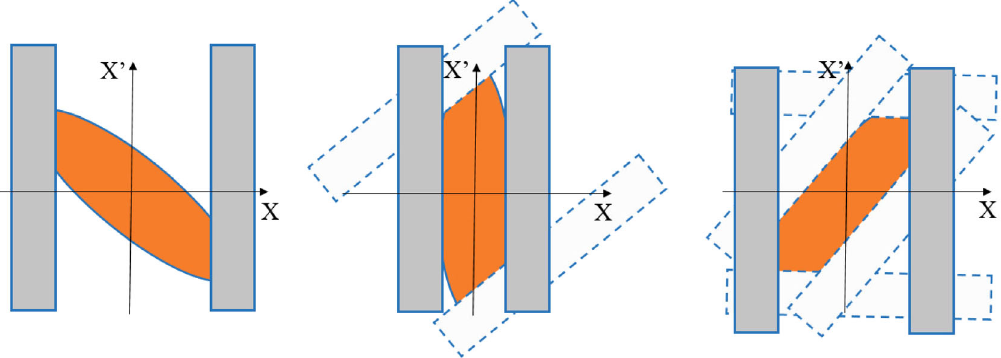
FIG. 20. Principle of beam collimation.